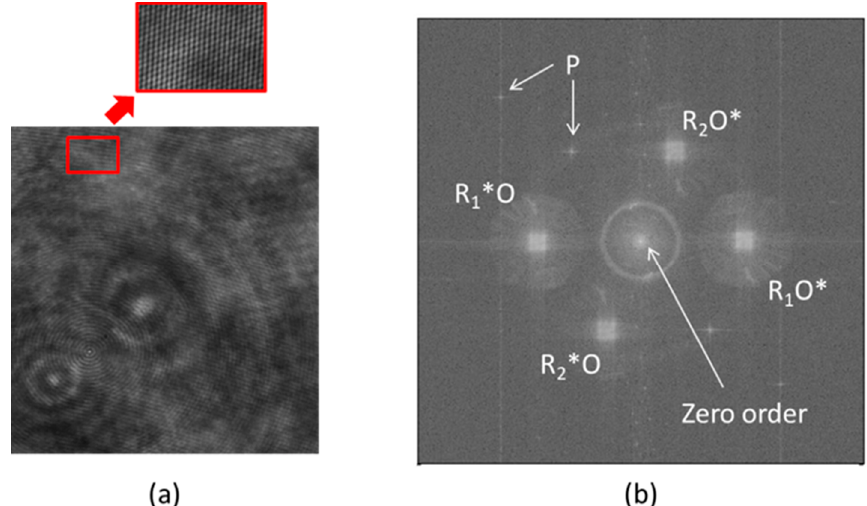
Figure 2. ( a ) Example of polarization hologram; in the inset the two fringe patterns are highlighted; ( b ) Fourier amplitude spectra of the hologram: the frequencies of the zero-order of diffraction, of the virtual and real images, and of parasitic interferences (P) are clearly visible.